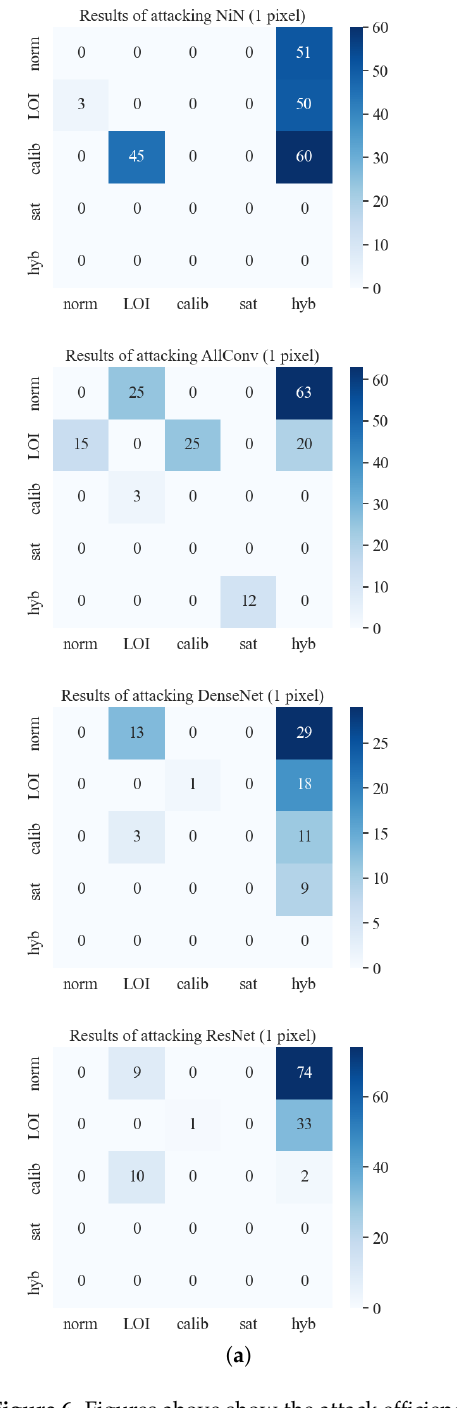
Figure 6. Figures above show the attack efficiency of perturbing 1 pixel and 3 pixels under 2000 times non-target attacks in the same dataset. The darker color shades represent the greater number of success attacks. ( a ) The result of target attacks by perturbing 1 pixel of an input matrix for each network. ( b ) The result of target attacks by perturbing 3 pixels of an input matrix for each network. AllConv: all convolution network. NiN: Network in Network. Norm: the unattacked state. LOI: LO intensity attacks. Calib: calibration attacks. Sat: saturation attacks. Hyb: the hybrids